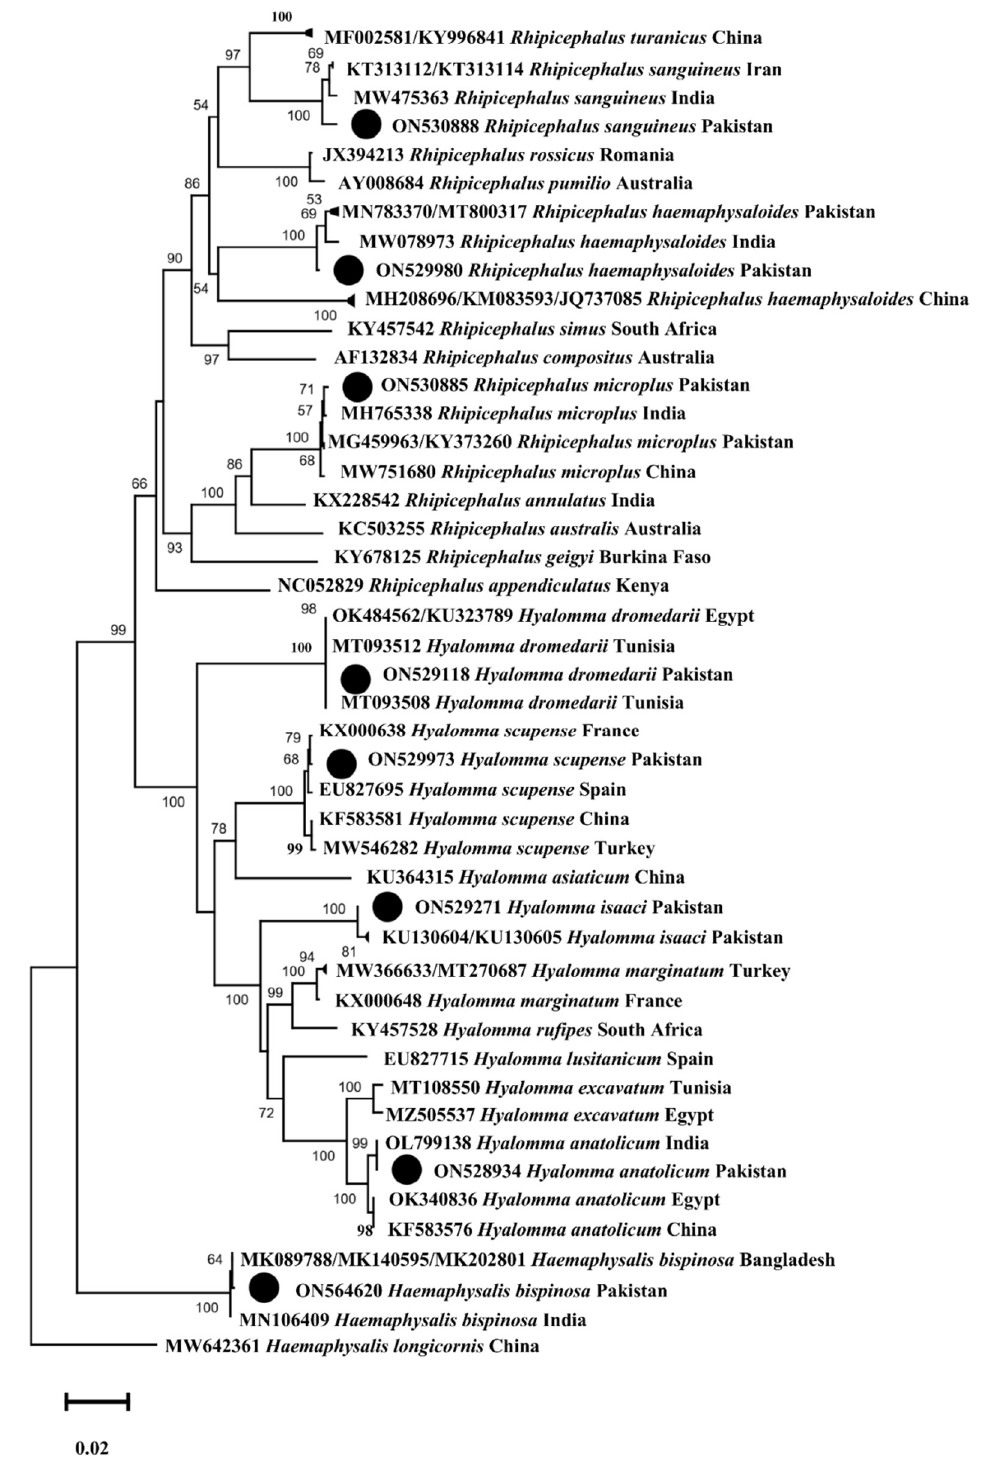
Figure 5. Maximum likelihood phylogenetic tree based on cox1 sequences of Hy. dromedarii , Hy. anatolicum , Hy. scupense , Hy. isaaci , Ha. bispinosa , R. microplus , R. sanguineus and R. haemaphysaloides . Haemaphysalis longicornis was used as an outgroup, using supporting values (1000 replicons) at each node. The scale bar indicates the number of substitutions per site. The obtained sequences were represented with black circles.